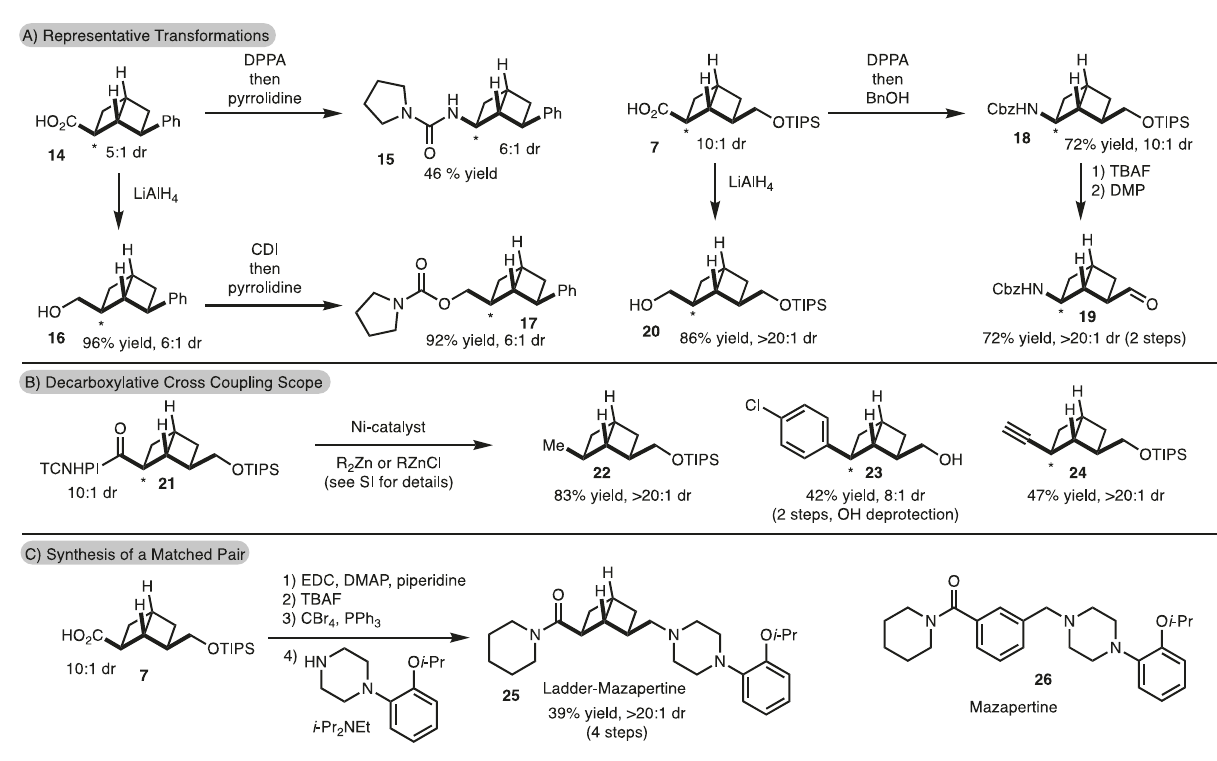
Fig. 3 | Derivatization of[2]-ladderane building blocks. A Transformation of the ladderane building block to other structures of relevance in medicinal chemistry. B Ni-catalyzed cross-coupling of redox-active esters. C Synthesis of ladder-